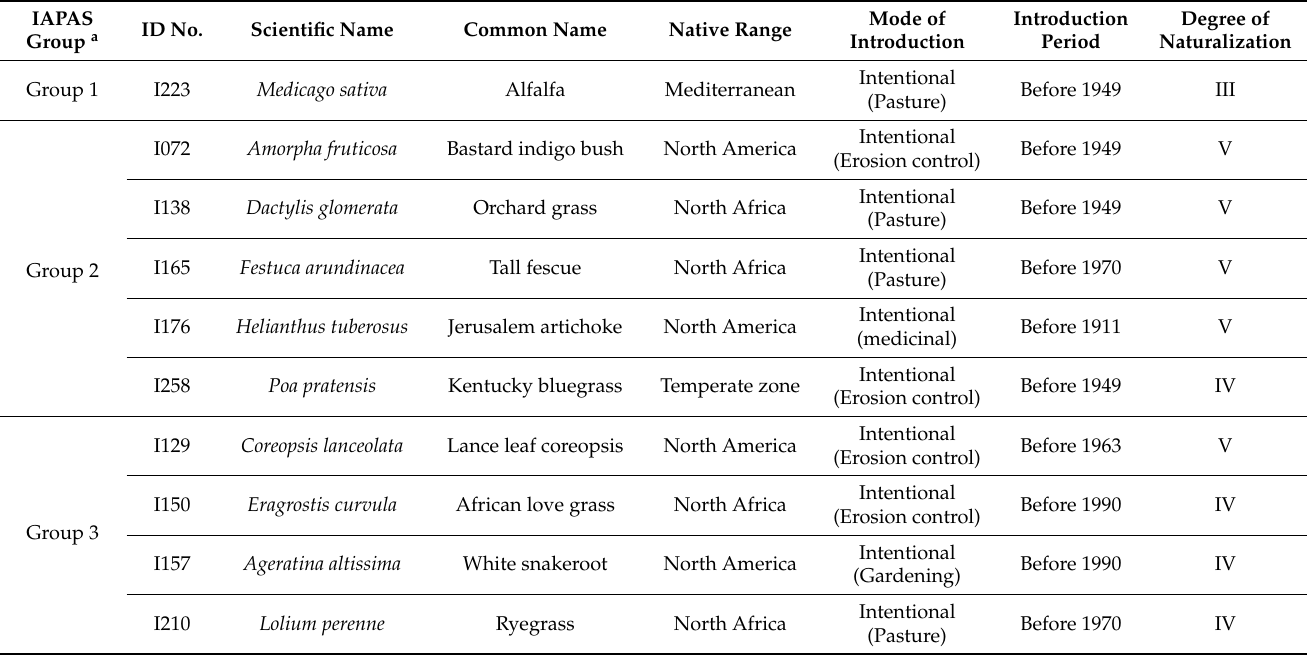
Table 1. List of intentionally introduced alien plant species (IIAPS) used in the species distribution model. IAPAS Group